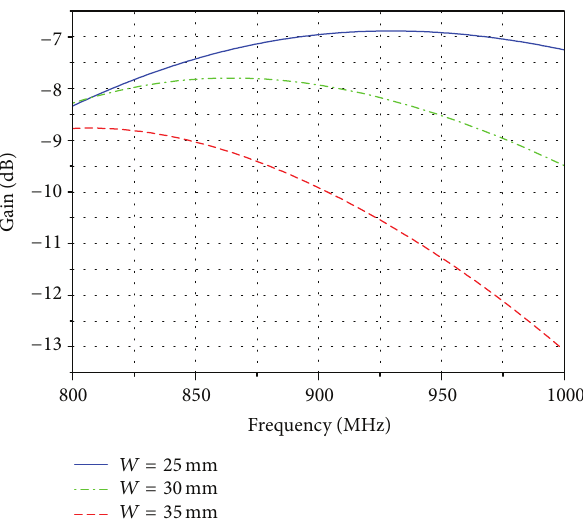
Figure 9: Antenna input impedance for different thicknesses of the transmission line.